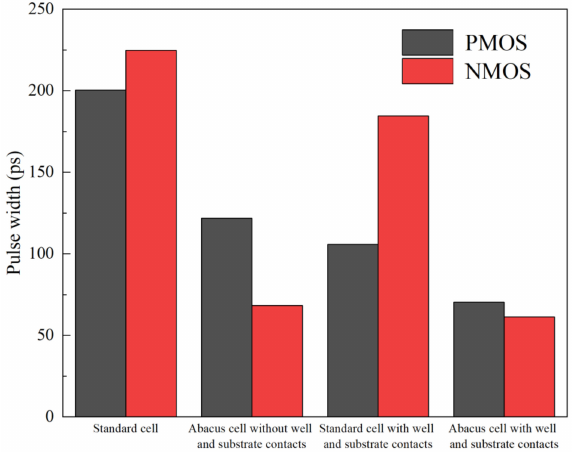
Figure 4. Pulse width simulations for the unhardened and abacus-hardened PMOS and NMOS ( LET = 100 MeV · cm 2 /mg, V dd = 1.1 V).